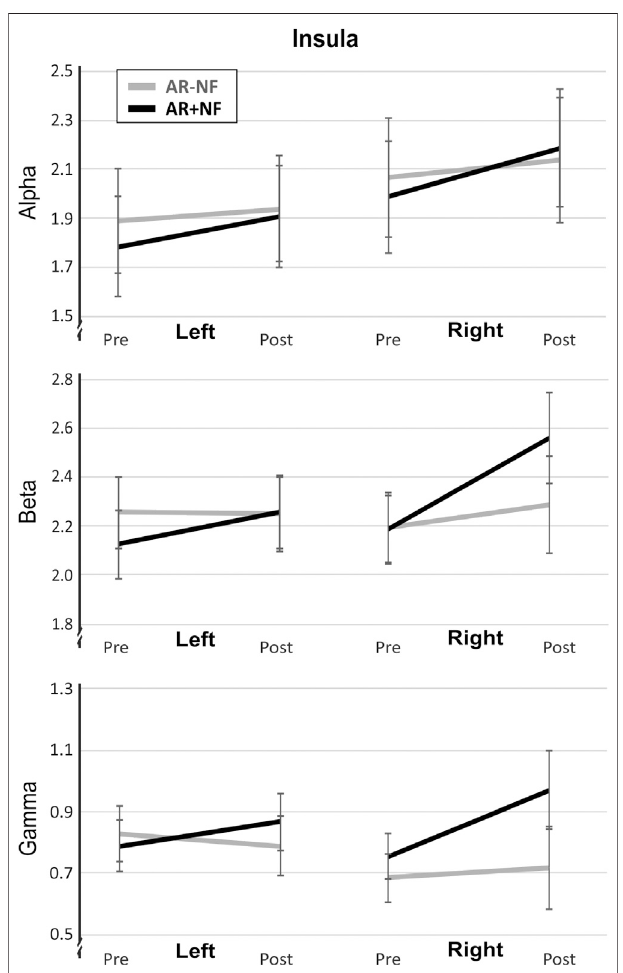
FIGURE 4 | Lateralized activity differences in insular cortex activity after AR meditation. Mean and standard error of the mean are shown. Units are nA/mm 3 .